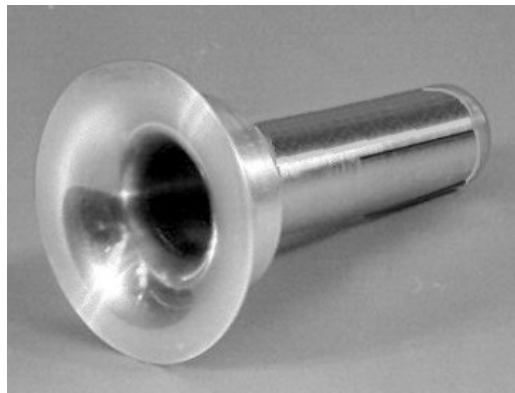
Figure 6. Photograph of the outer part N (cf. Figure 4) of the radial inflow into the annular secondary inlet into the mixing tube.